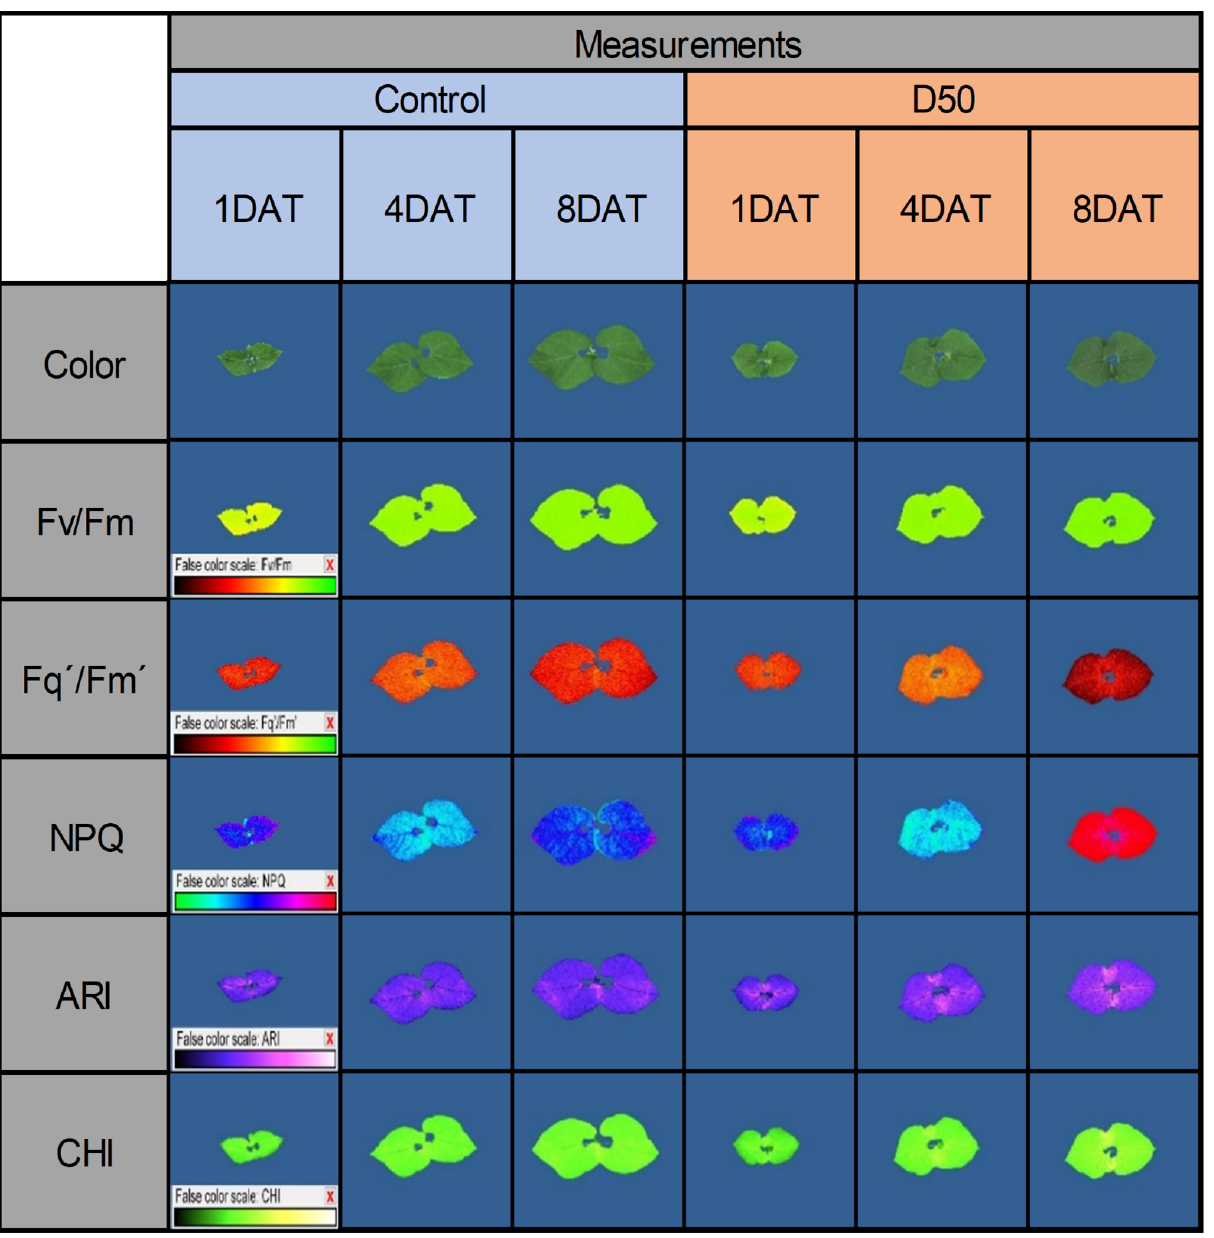
Figure 4. Common bean color and pseudo-color images showing the maximum quantum yield of PSII (Fv/Fm), the effective quantum yield of PSII (Fq ′ /Fm ′ ), non-photochemical quenching (NPQ), the anthocyanin index (ARI), and the chlorophyll index (CHI) captured by CropReporter on the first (1 DAT), fourth (4 DAT) and eighth (8 DAT) day of the experiment in control and under drought treatment (D50).